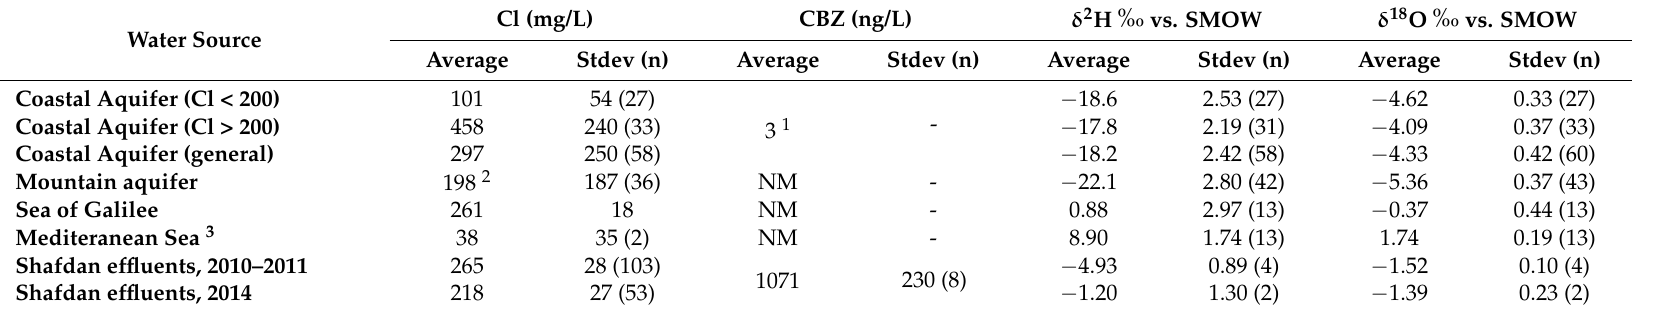
Table 3. Cl, CBZ and isotopic composition average values of different types of water